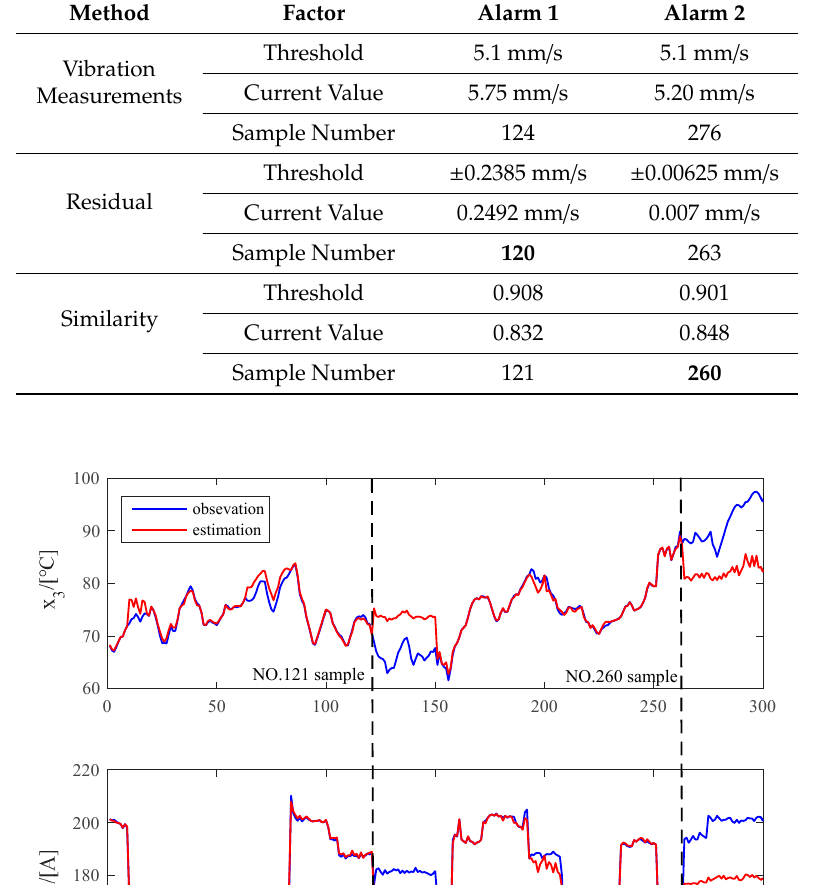
Table 7. Comparison of di ff erent failure detection method.